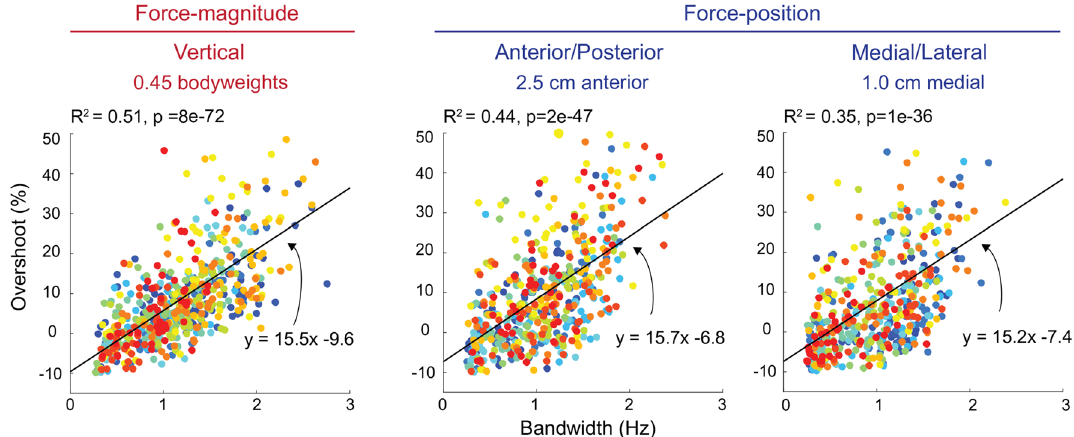
Figure 5. Representative findings from force-magnitude control (0.45 bodyweights), and force-position control (2.5 cm anterior and 1.0 cm medial). We fit a linear mixed-effects model to the data and plot the resultant linear fit as the black line. Each data point corresponds to the results from a single-step response while each color corresponds to a different participant. The R 2 value for the fit is shown alongside the p-value, and equation of the line.